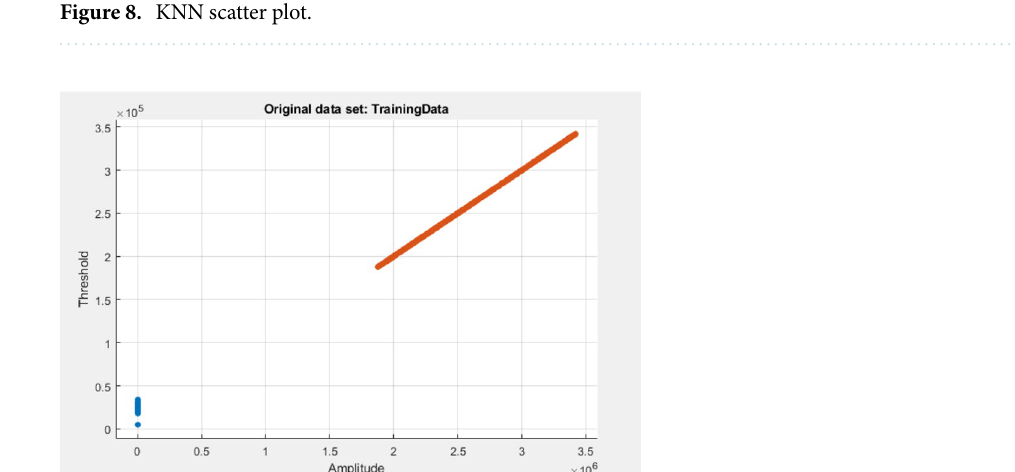
Figure 8. KNN scatter plot.